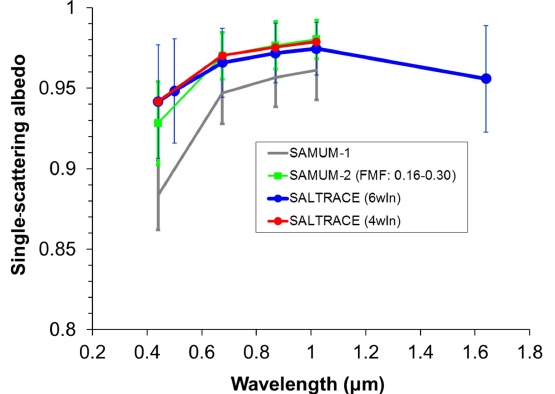
Figure 4. Single-scattering albedo as a function of wavelength for SALTRACE as well as the SAMUM campaigns. Average values for dust cases in each campaign are provided. Bars indicate ± 1 standard deviation. For SAMUM-2, only cases with low fine-mode fractions (FMF) between 0.16 and 0.30 are considered. For SALTRACE data, retrievals using six wavelength (6wln) and four wavelength (4wln) channels are shown.